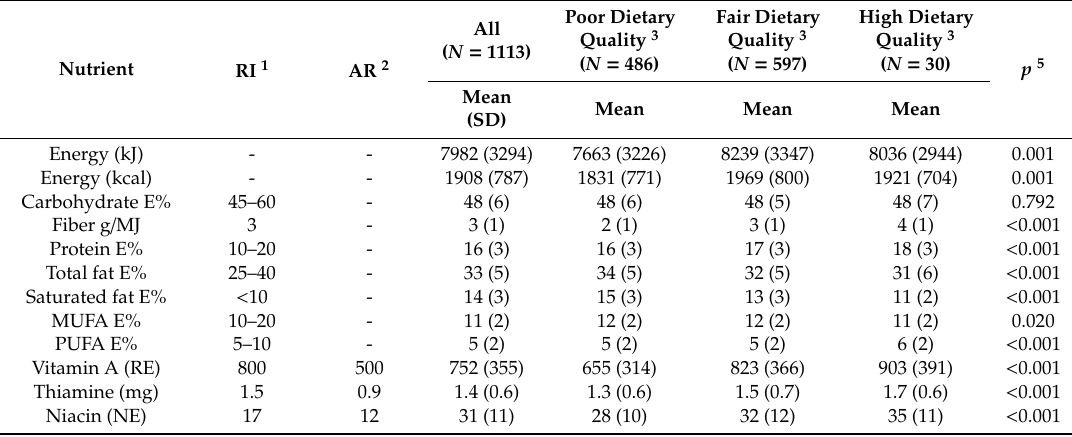
Table 4. Nutritional intake in pregnancy among the women in the GraviD cohort, assessed by a food frequency